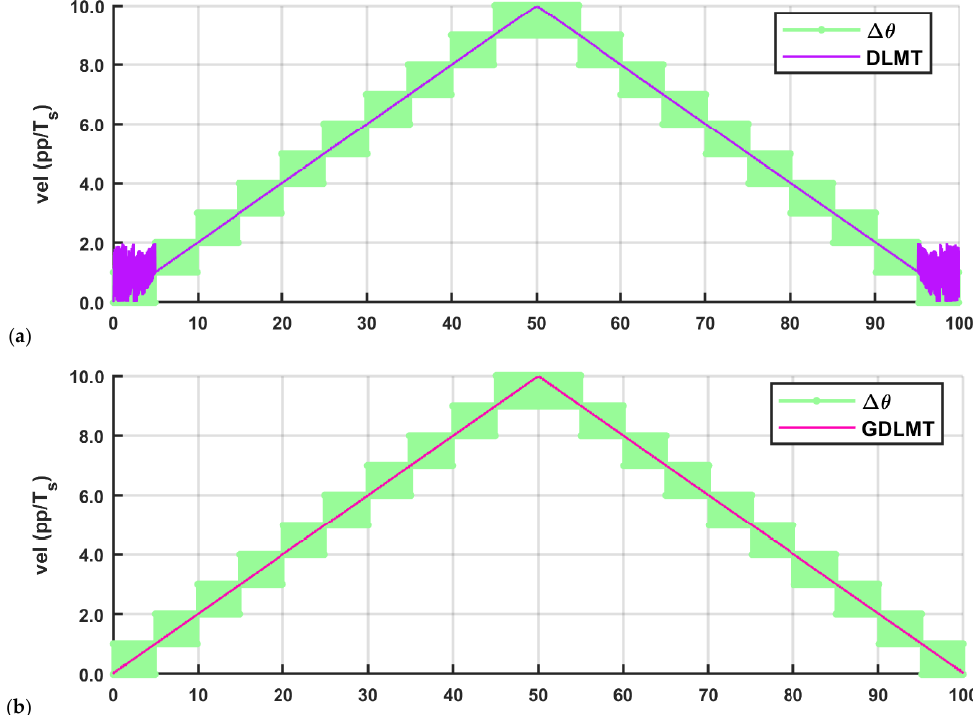
Figure 9. Comparison of the DLMT method and the GDLMT method at ramp speed: ( a ) pure DLMT method; ( b ) GDLMT method.